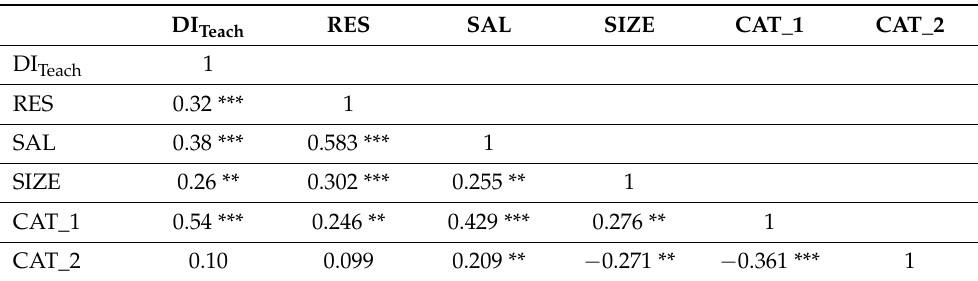
Table 5. Correlation matrix for teaching dimension.